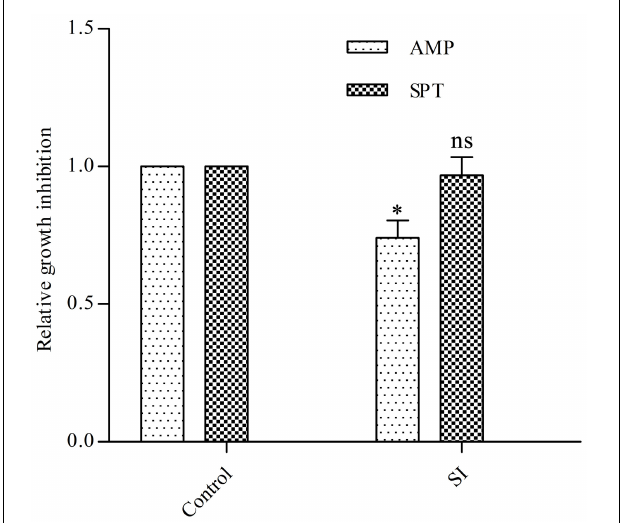
FIGURE 1 | Effects of EGCG on antibiotic resistance and cell survival. A sub-inhibitory (SI) dose of EGCG (400 µ g/ml) increases resistance to ampicillin. The growth inhibition diameter was measured around disks containing 20 µ g ampicillin (AMP) or 100 µ g spectinomycin (SPT). Cells without EGCG treatment were used as a control. y axis represents values normalized by the average diameter obtained for the control. All values were obtained from at least three biological replicates. Error bars indicate standard deviation (SD). ∗ P < 0.05. ns, not statistically